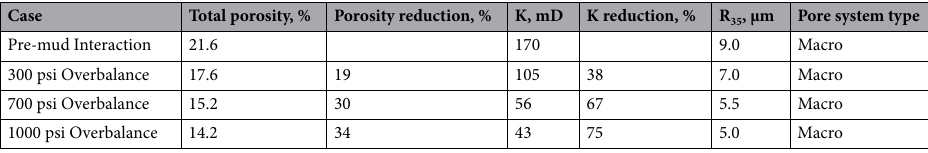
Table 4. Pore system characteristics with increasing overbalance